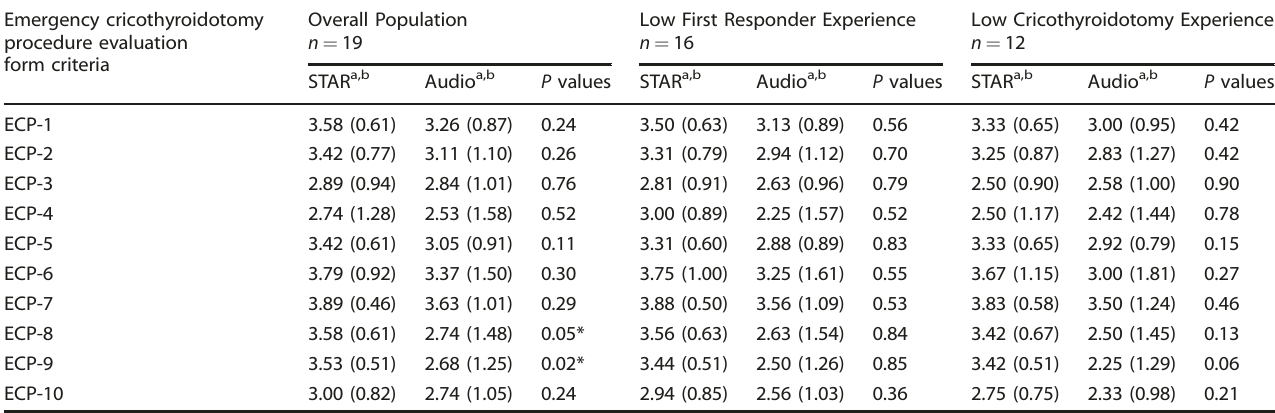
Table 2. Averaged results for the different criteria of the Emergency Cricothyroidotomy Performance scores for the Overall Population and both the experience-based subgroups.